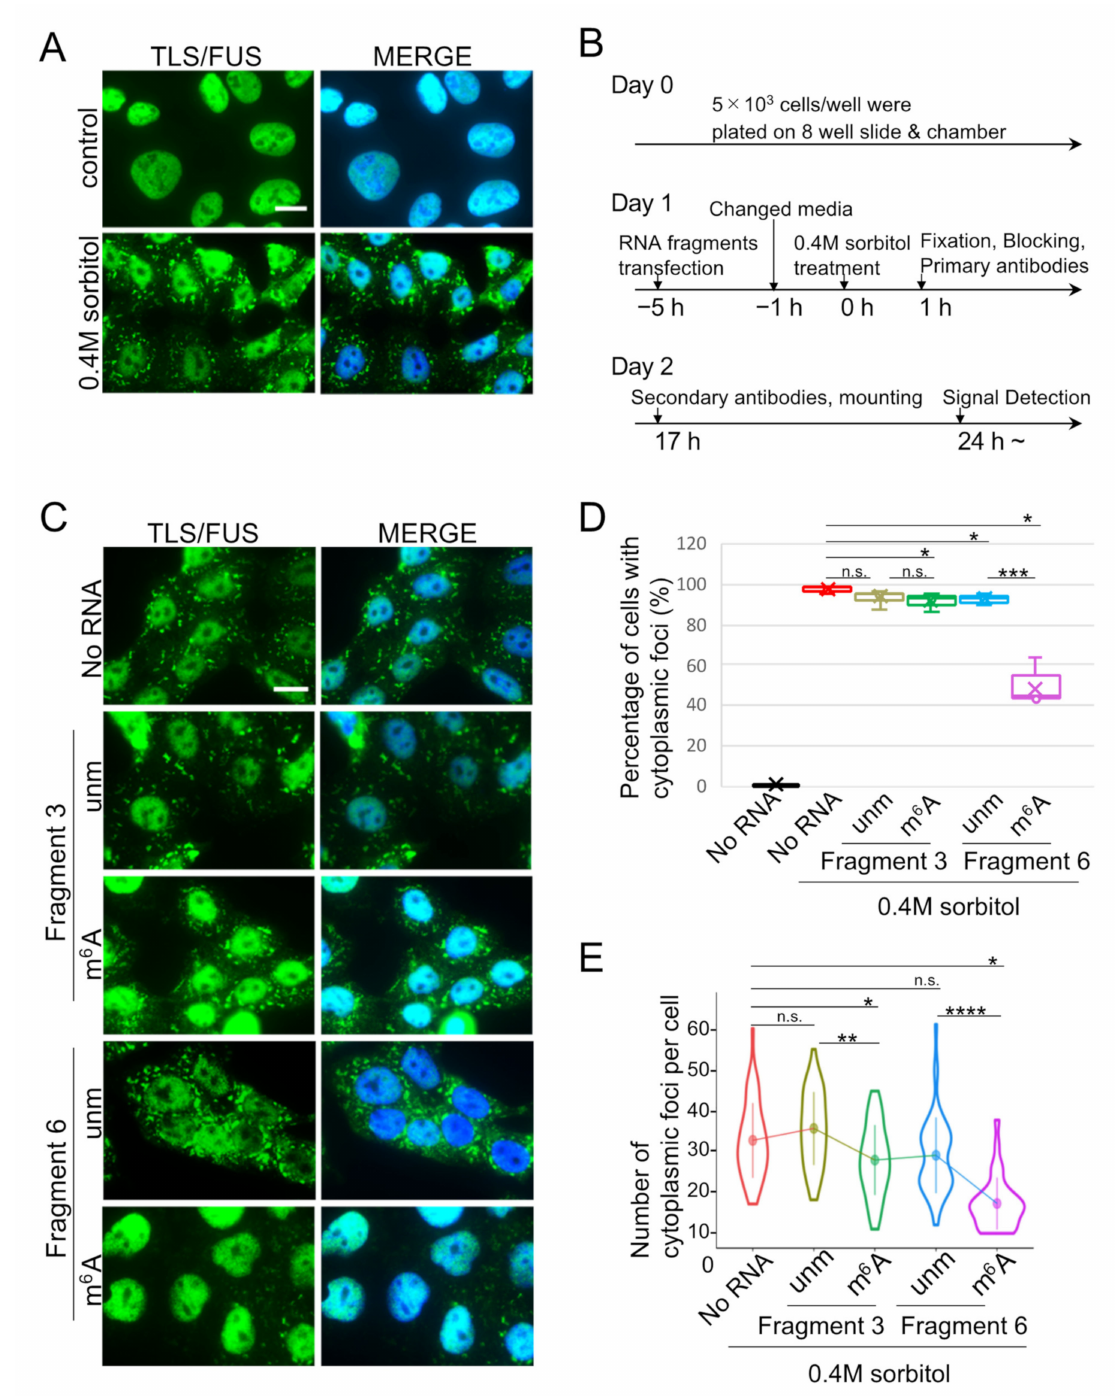
Figure 3. RNA fragments reduced cytoplasmic TLS/FUS foci after sorbitol treatment. ( A ) Representative ICC images of HAP1 cells with or without 0.4M sorbitol treatment for 1 h. Scale bar = 10 µ m. ( B ) Experimental design of ( C ). RNA fragments were transfected prior to 0.4M sorbitol treatment, and ICC was conducted after 1 h of sorbitol treatment. ( C ) RNA Fragments 3 and 6 with or without m 6 A modification were transfected to HAP1 cells as in ( B ), and followed by sorbitol treatment and ICC. Representative images of ICC are shown. MERGE images indicate the layered images of TLS/FUS and DAPI (for nuclei staining). Scale bar = 10 µ m. ( D , E ) Percentage of cells with cytoplasmic TLS/FUS foci ( D ) or number of cytoplasmic foci per cell (E) were counted and quantified using images in ( C ) and Supplementary Materials Figure S2. n = 10 ( D ) or 50 ( E ) for each sample. n.s., not significant; unm, unmodified fragments; m 6 A, m 6 A modified fragments. * p < 0.05, ** p < 0.01, *** p < 0.005, **** p <